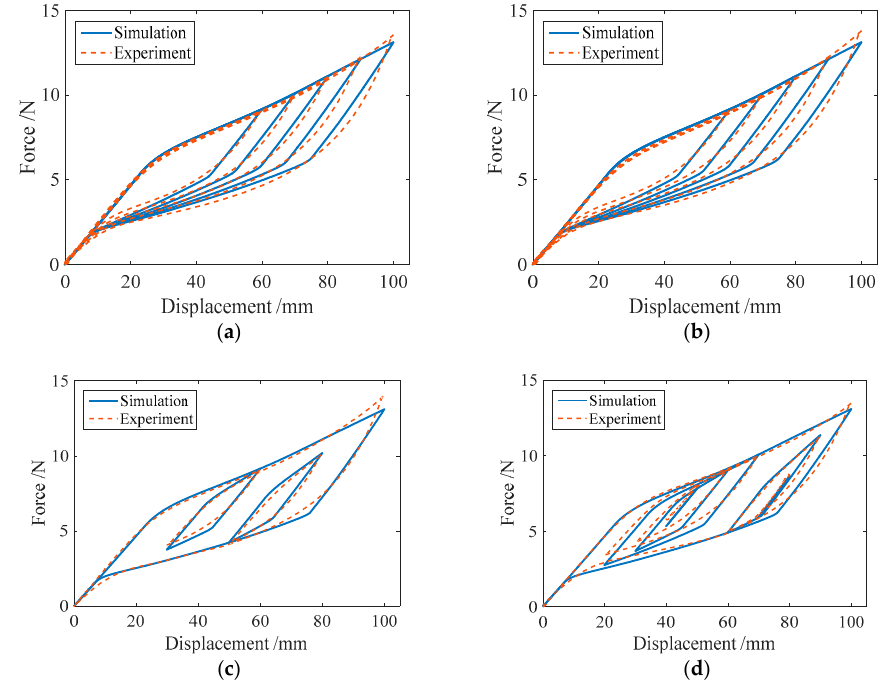
Figure 11. Simulation results of the force-displacement relationship of the specimen SMA-S1 in different loading cases: ( a ) Case I; ( b ) Case II; ( c ) Case III; and ( d ) Case IV.